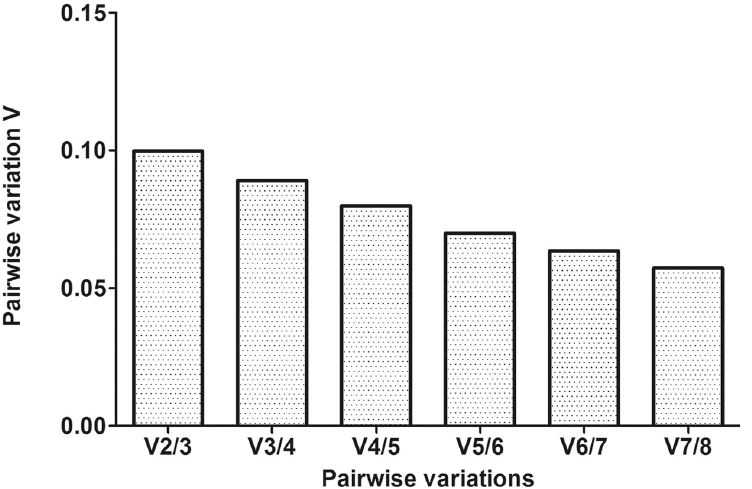
Fig 1. Evaluation of reference genes using geNorm across all tested samples. Determination of the optimal number of reference genes for normalization relied on the pairwise variation ( Vn/n + 1 ) analysis. Every bar represents a change in normalization accuracy with the stepwise addition more of reference genes. The figure indicates that there is no need to include more than two genes into the normalization factor. https://doi.org/10.1371/journal.pone.0210087.g001 standard deviation of 0.322, followed by B2M with a mean standard deviation of 0.352.The final ranking of reference genes was performed using the RankAggreg package that integrated the results obtained from geNorm, NormFinder, BestKeeper, and the Δ Ct method (Table 3). The final rankings revealed that GAPDH was the most suitable reference genes (Table 3).